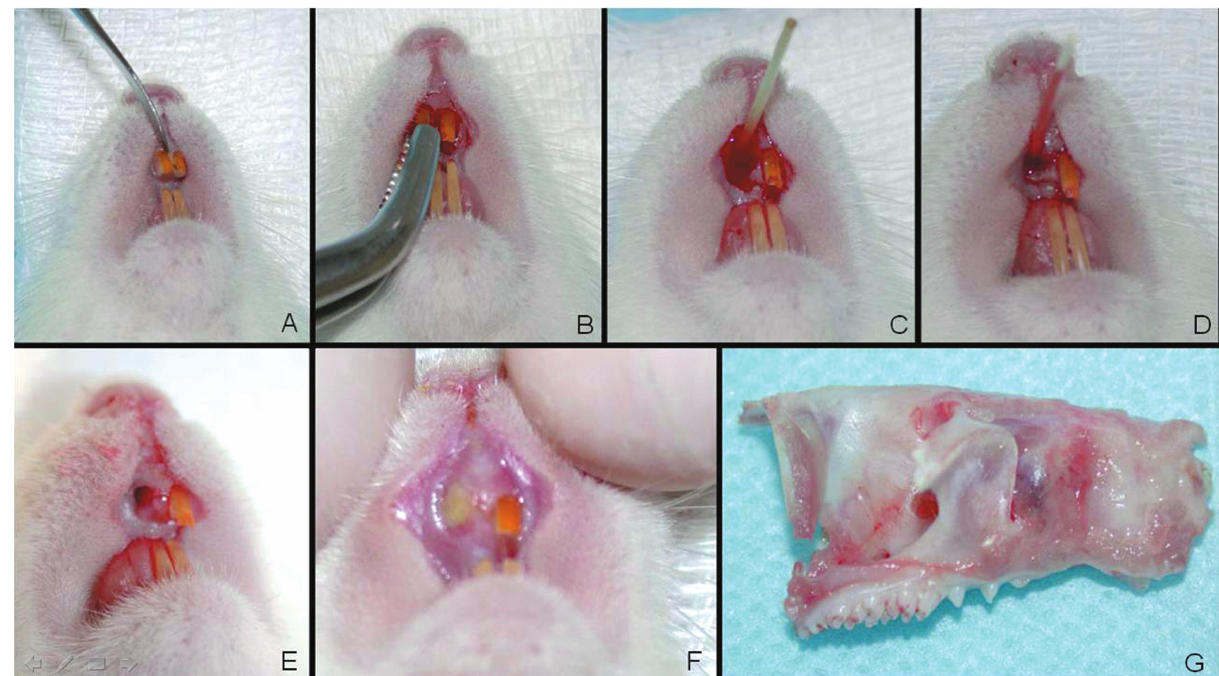
Figure 1- Experimental procedures for experimental alveolitis induction in rats. A) Luxation of right maxillary incisor; B) Extraction; C) Application of adrenaline solution 1:1,000 1 min; D) Inoculation of purulent secretion into the socket; E) Socket aspect after ischemia and contamination; F) Socket aspect after 3 days of contamination showing pus and gingival edema; G) Right maxilla specimen obtained to histological